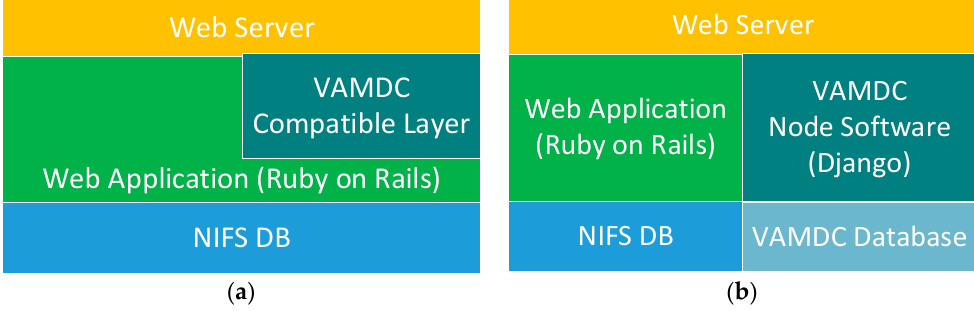
Figure 4. The two possible integration plans. ( a ) Plan A was to implement the VAMDC standards in the NIFS DB by building node compatibility into the existing system. ( b ) Plan B was to build another NIFS DB system dedicated to the VAMDC portal, which was compatible with the VAMDC node software, Django.